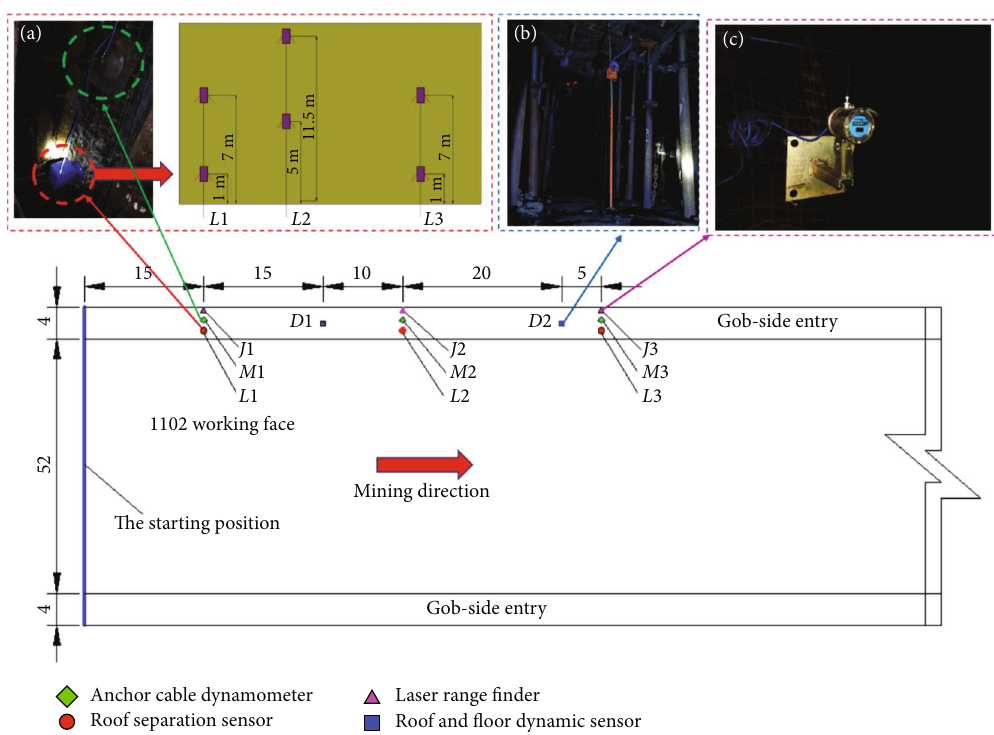
Figure 12: Roadway monitoring point layout.